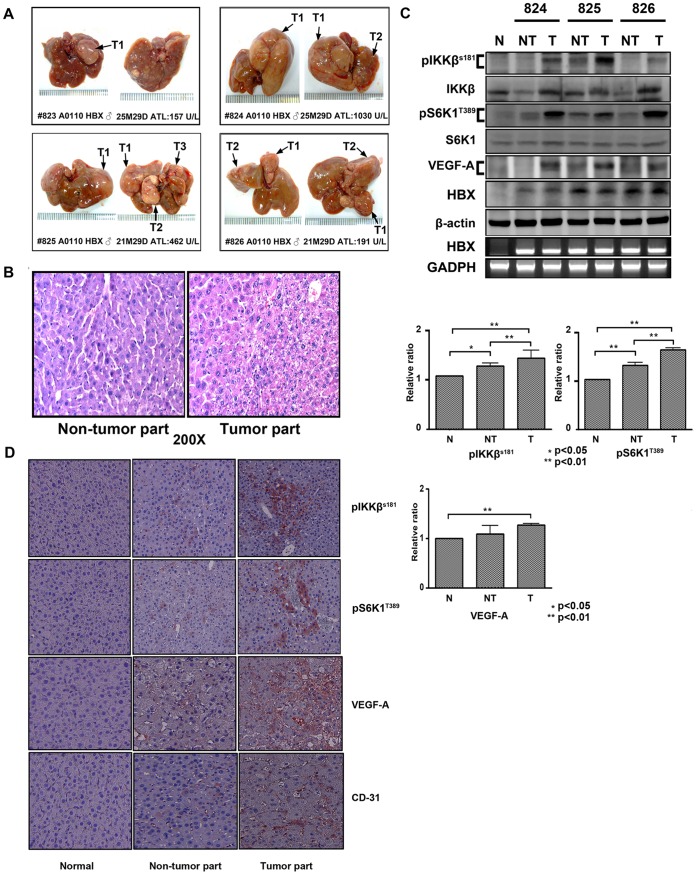
Increased expression levels of pIKKβ(S181), pS6K1(T389), and VEGF-A in liver tissues of HBx transgenic mice.(A). A gross view of representative liver tumors (T1, T2, T3) developed in HBx transgenic mice in several months of breeding. The ALT values are shown. (B). The H&E staining of non-tumor and tumor parts in HBx transgenic mice. (C). The expression levels of pIKKβ (S181), IKKβ, pS6K1 (T389), S6K1, VEGF-A, HBx, and β-actin detected by Western blotting in non-tumor and tumor parts of liver tissues of three HBx transgenic mice (#824, #825, and #826) were compared to the normal liver tissues of the wild-type age-matched mouse. The HBx mRNA levels were also measured by RT-PCR and the GAPDH mRNA levels were used as an internal control. The relative levels of pIKKβ (S181), pS6K1 (T389), and VEGF-A were quantified by densitometry and normalized with total IKKβ, total S6K1, and actin. Results are shown as ratios of average levels of pIKKβ (S181) pS6K1 (T389), and VEGF-A in non-tumor and tumor parts of liver tissues of three HBx transgenic mice (#824, #825, and #826) relative to that in the normal liver tissues of the wild-type age-matched mouse (set as 1). Data are shown as means ± S.D. of measurements of three mice. (D). Immunohistochemistry analyses show expression levels of pIKKβ (S181), pS6K1 (T389), VEGF-A, and CD31 in normal liver tissues of the wild-type mouse, and non-tumor and tumor parts of liver tissues of HBx transgenic mice. One representative data are shown. N = 3.